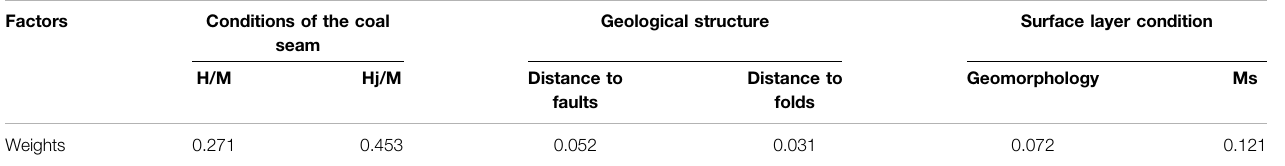
TABLE 5 | Weights of factors for prediction of the degree of surface damage.